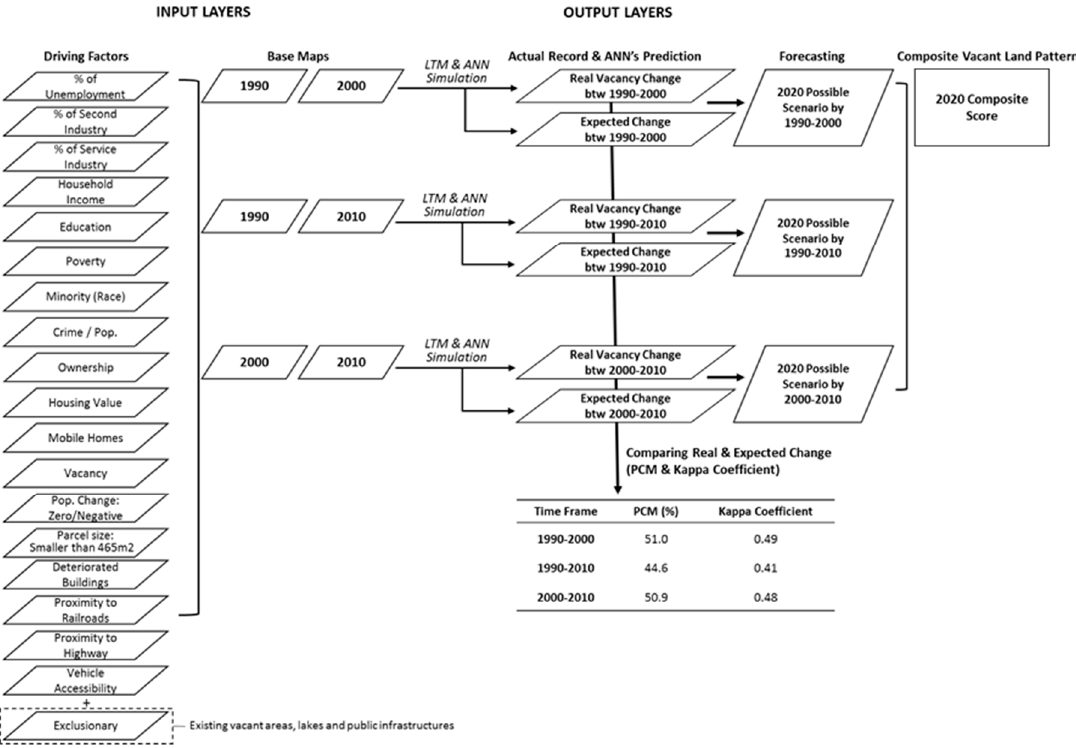
Figure 2. LTM process diagram showing input factors, input patterns, and output comparison map.